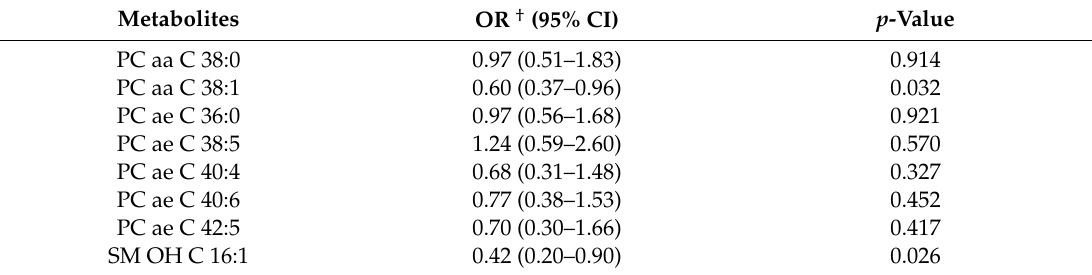
Table 5. Association between hypertension risk (OR and 95% CI) and